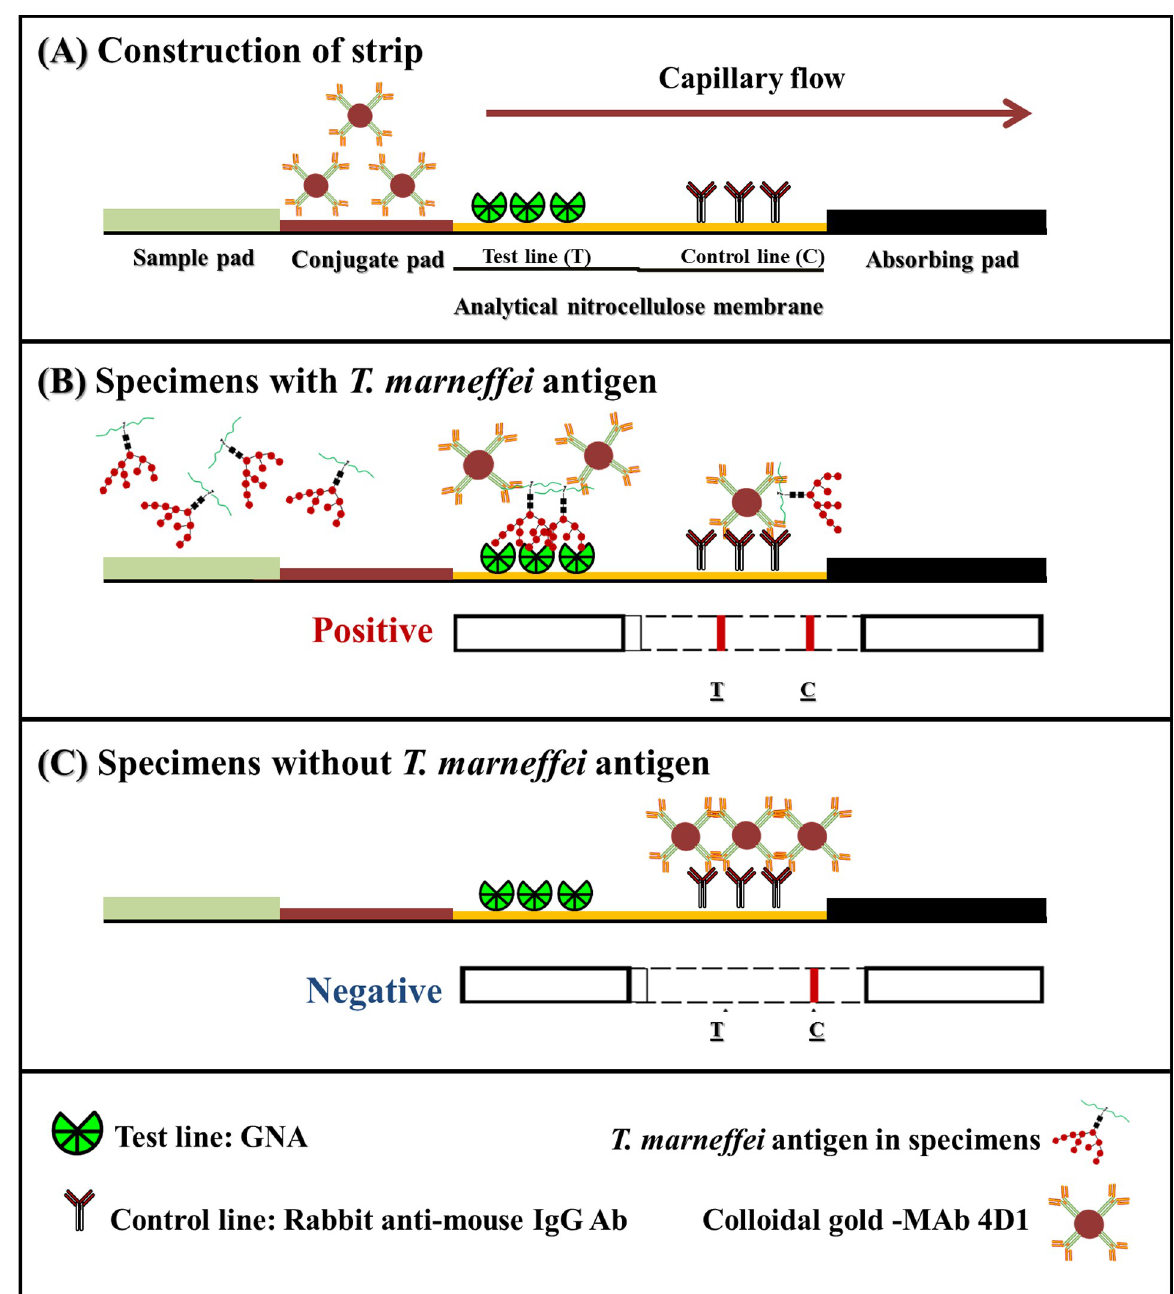
Fig 2. The cartoon formats of GNA–MAb 4D1 sandwich ICT strip for rapid detection of T . marneffei antigen from a clinical sample. (A), the schematic presentation of the positions where MAb 4D1, GNA and rabbit anti-mouse IgG antibodies are immobilized in an analytical nitrocellulose membrane. (B), the reactions that occur on the MAb 4D1 – GNA strip in the presence of T . marneffei antigen and (C), in the absence of T . marneffei antigens. The red–purple color of colloidal gold conjugate appears at the test line and/or control line, depending on the presence of T . marneffei in the clinical